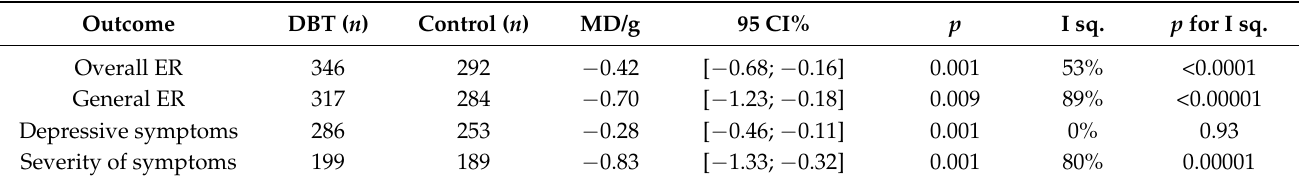
Table A2. Overall analysis